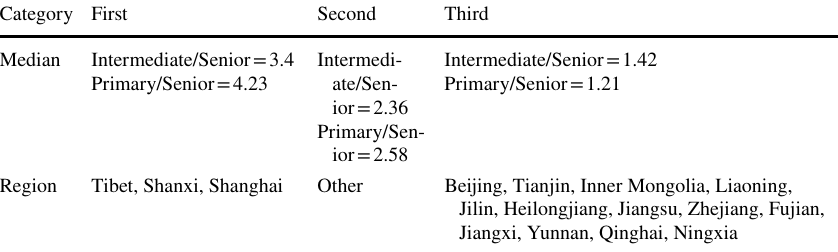
Table 5 Ratio of professional titles of teachers (junior high school) Category First